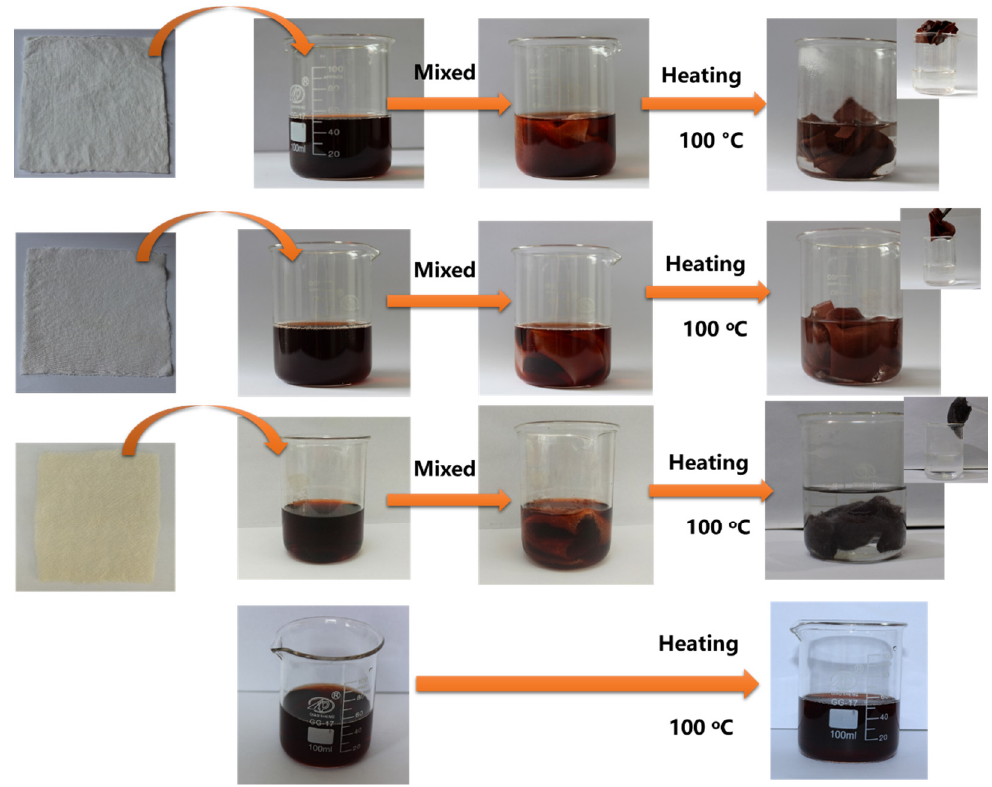
Figure 3. Schematic of the heat-induced self-assembly of mixed Ag, Au, and Pt NPs on cotton, silk, and wool textiles (110 mg/L).